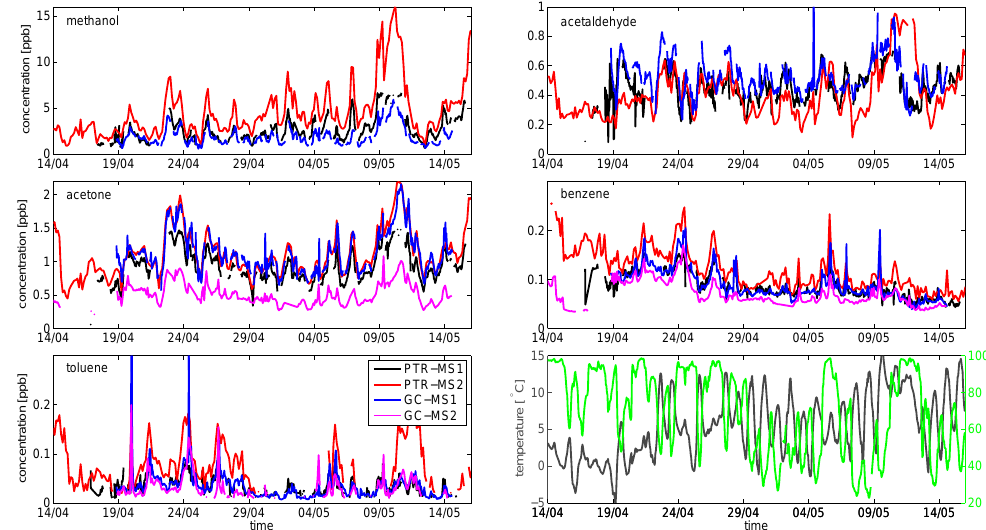
Figure 2. Concentrations of methanol, acetaldehyde, acetone, benzene and toluene measured with PTR-MS1, PTR-MS2, GC-MS1 and GC- MS2 and ambient temperature and relative humidity during the measurement campaign. Hourly averages were calculated for the PTR-MS instruments. For the GC-MS instruments, all data are